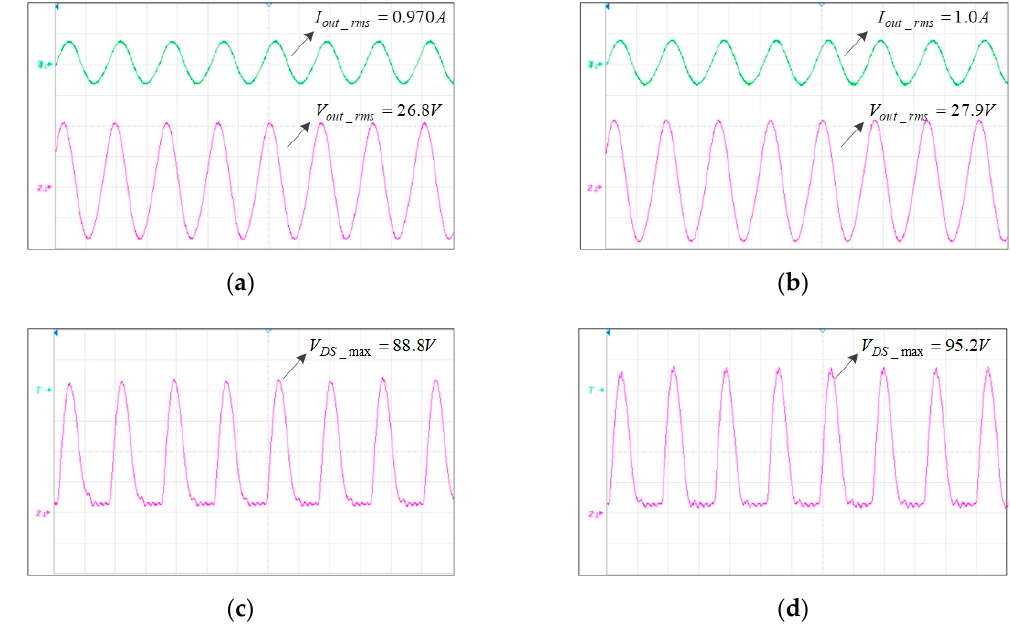
Figure 8. ( a ) Load current and voltage waveform of PCL before optimization; ( b ) load current and voltage waveform of PCL after optimization; ( c ) drain-source voltage waveform of PCL before optimization; ( d ) drain-source voltage waveform of PCL after optimization.